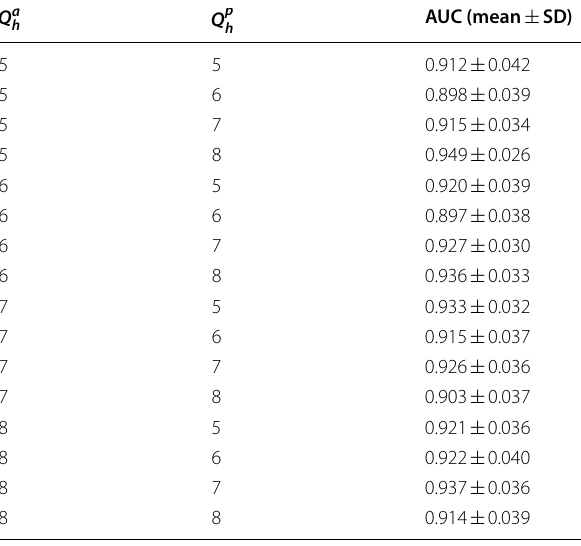
Table 5 AUC values of HAV (or T 25 to 64 and the t -th root is set to be 2